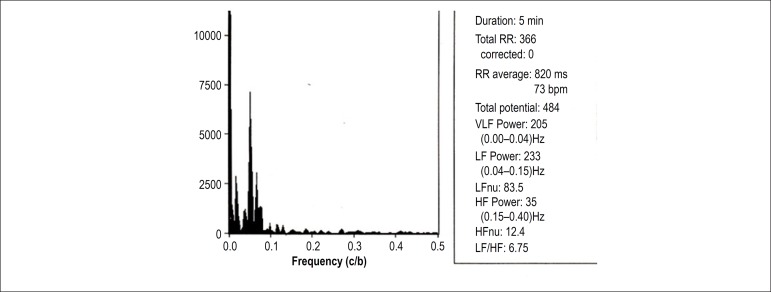
Spectral analysis of a female patient (62 years of age) without
orthostatic hypotension in supine position. RR: number of QRS in
sinus rhythm; VLF: very low frequency; LF: low frequency; HF: high
frequency; HFnu: HF normalized unit.